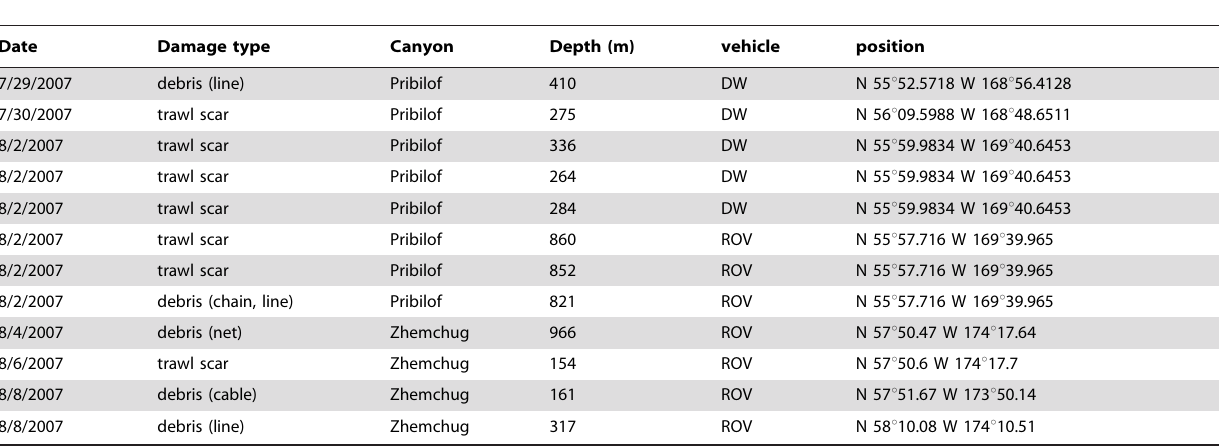
Coordinates represent the initial starting position of each dive. DW=Deep Worker.